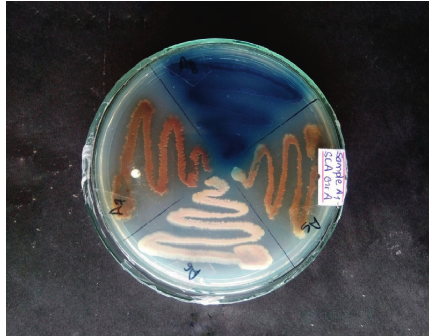
Figure 3: Production of pigment by sample A5, A6, A7, and A8 in the SCA